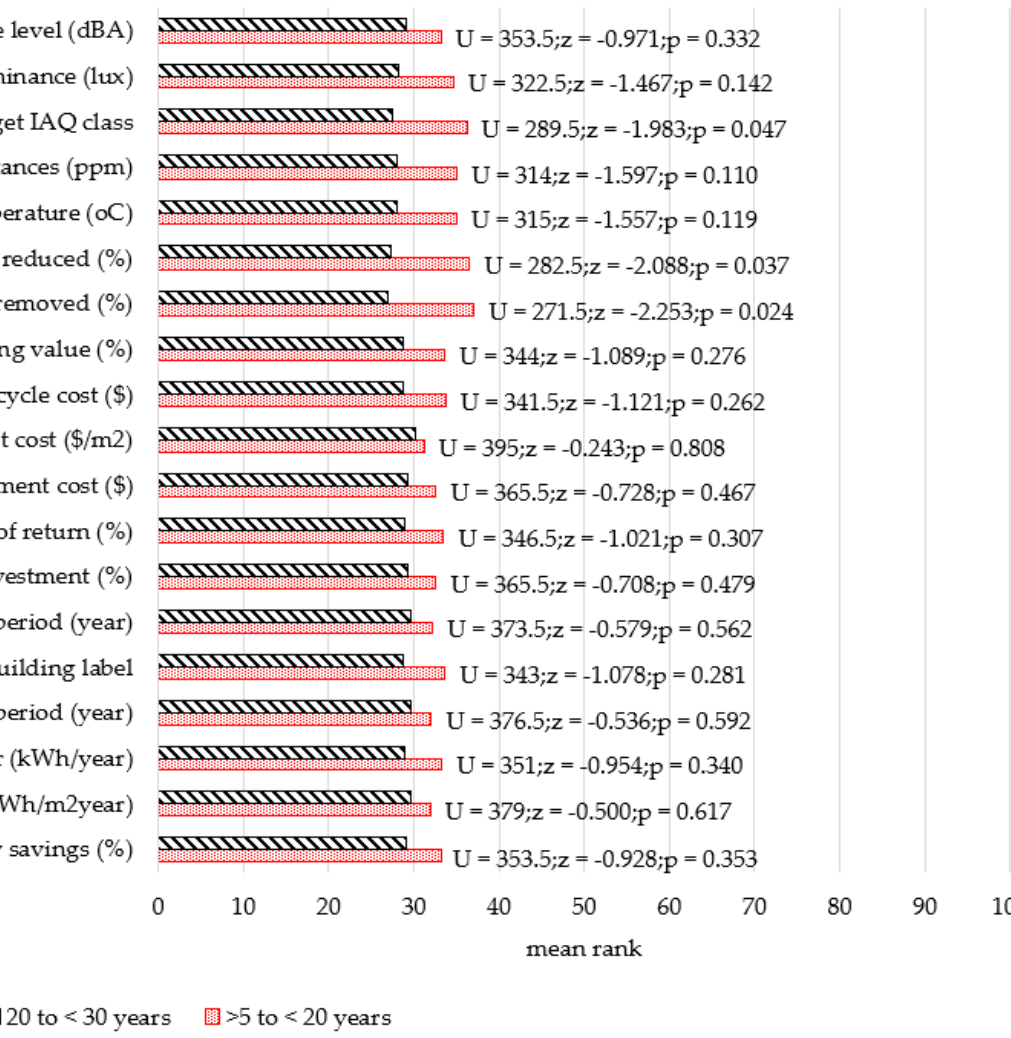
Figure A8. Mann – Whitney U-test results of G2 (work experience: G2b vs. G2c). Figure A8. Mann–Whitney U-test results of G2 (work experience: G2b vs.